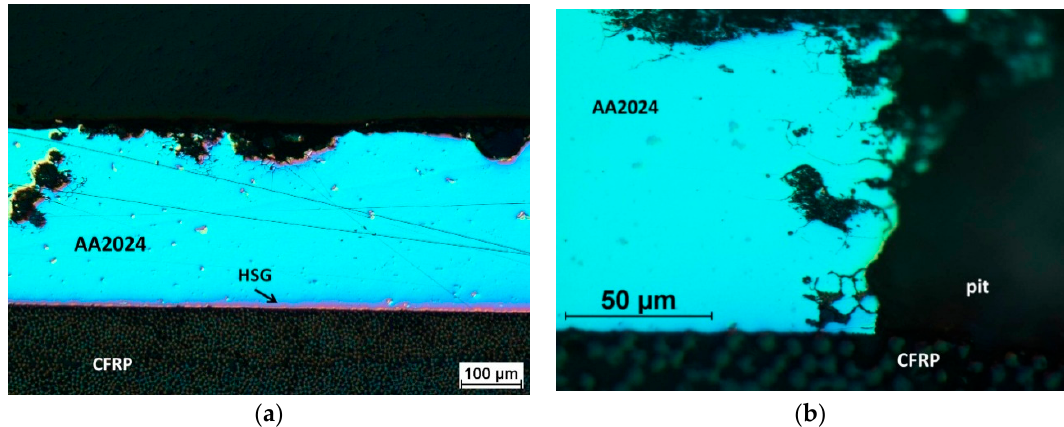
Figure 11. Aluminum alloy corrosion ( a ) and pitting area ( b ) in the Al-CFRP laminate after 12 weeks in a salt chamber; LM, Nomarski interference contrast.